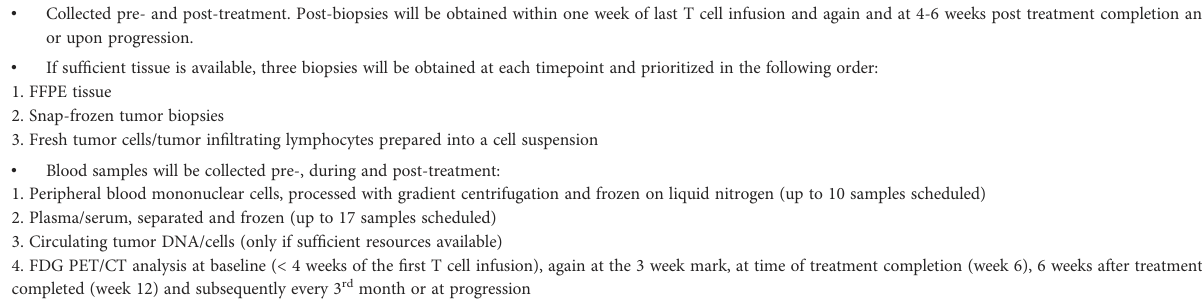
TABLE 4 Samples to be collected in the T-RAD